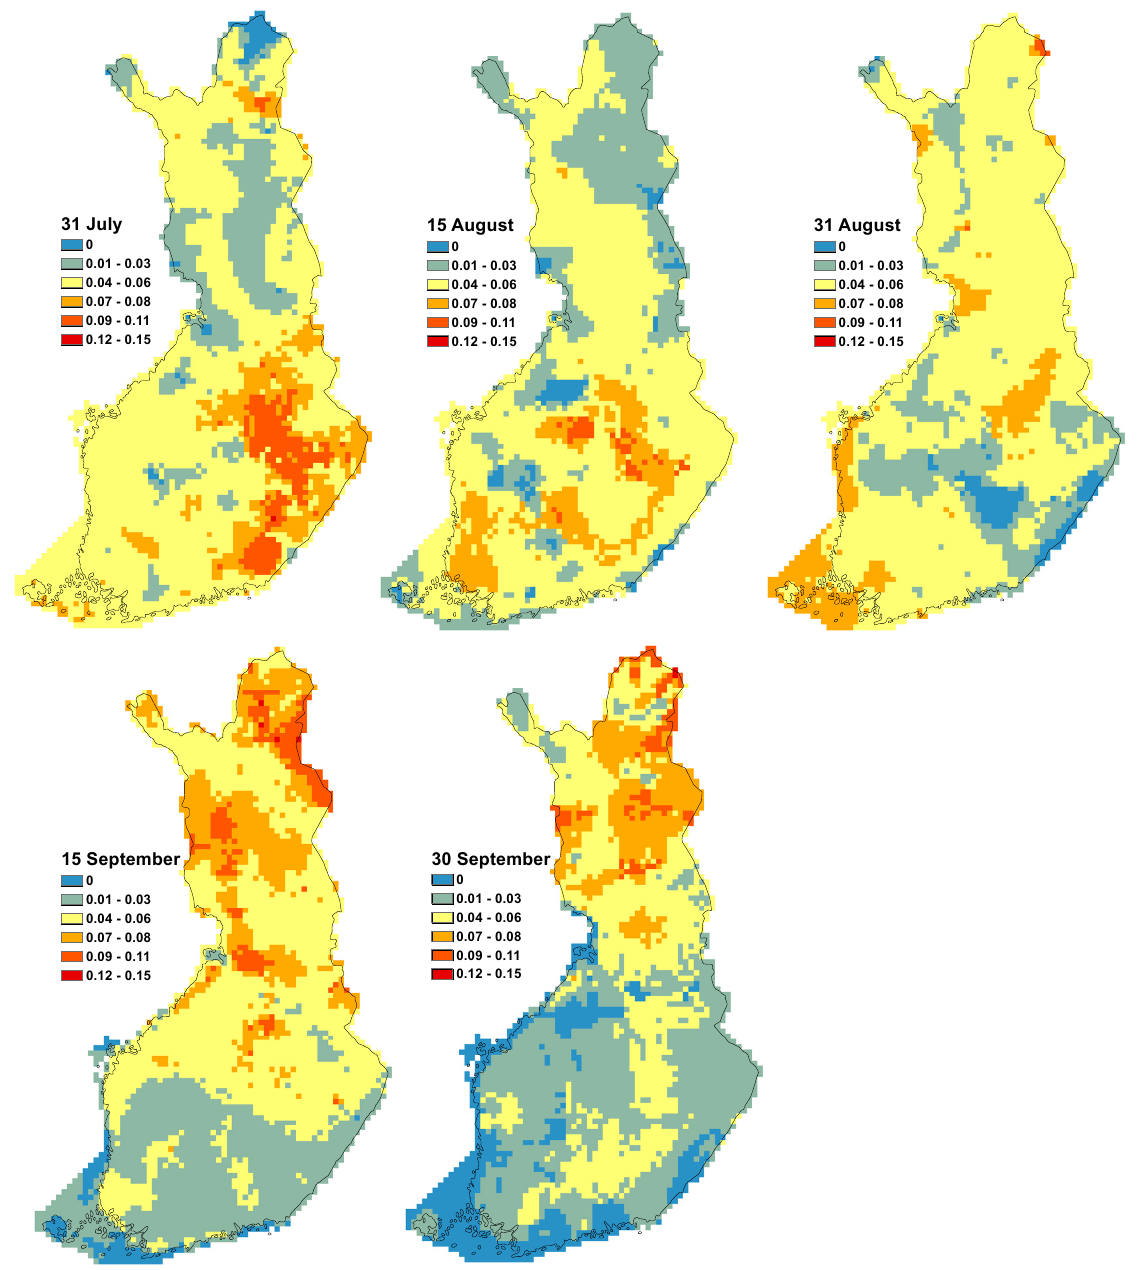
Fig. 1b. Probabilities of elevated temperatures of ≥3 °C that lasted at least for one week for the periods that ended on 31 July to 30